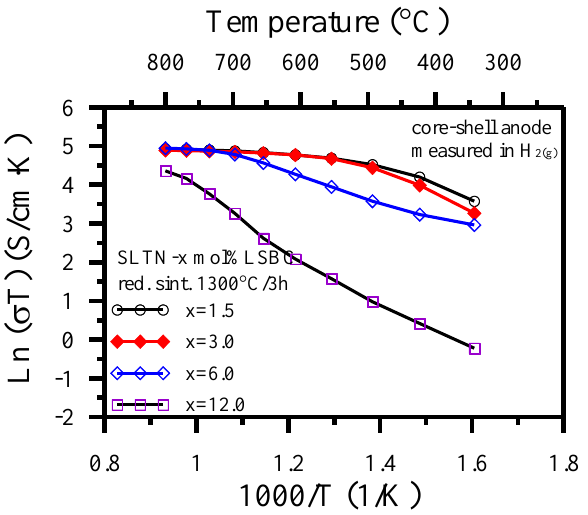
Figure 8. The conductivities of SLTN-x mole% LSBC core – shell anodes after 1300 °C/3 h sintering in activated carbon-reducing atmosphere as a function of measuring temperatures in H 2 atmos-